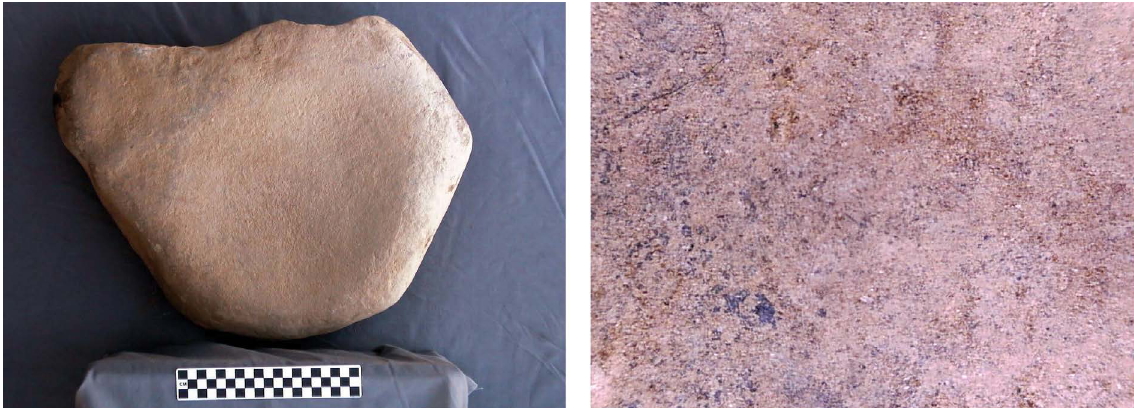
Figure 14. Grinding slab from Khirbat en-Nahas; sandstone rock. Photomicrograph (right) of centre of use surface shows pits, loose rock grains, surface levelling, and linear rock grain removal (striations). Image width = 7.5